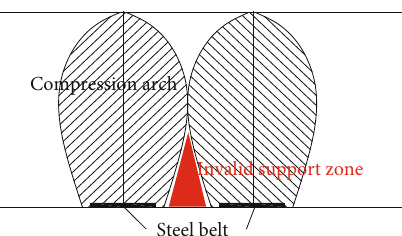
Figure 9: The relationship between bolt and surface support.